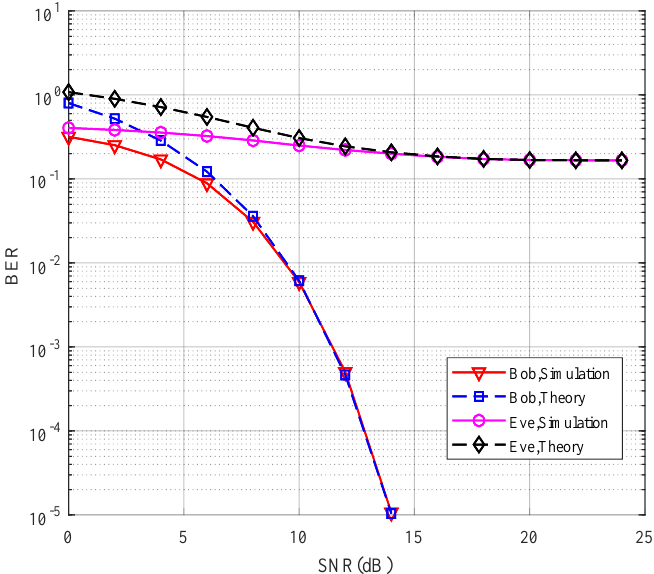
Figure 6. Bob’s and Eve’s theoretical and simulated BER performance for the proposed CIM-SDM scheme employing N t = 8, N r = 2, and QPSK.